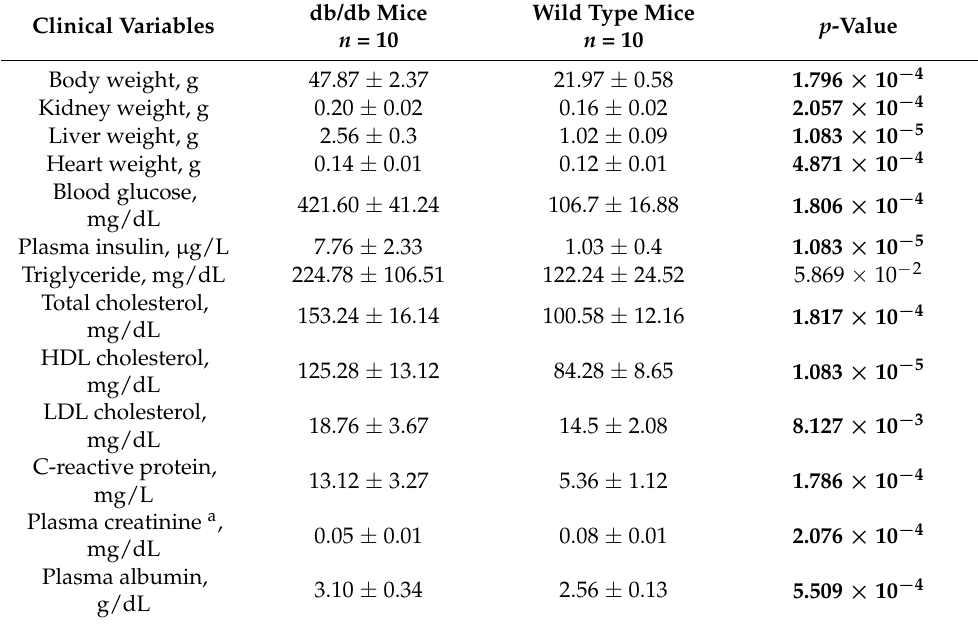
Table 4. Phenotypic and metabolic variables in db/db and wild type mice after 5 weeks of a high-fat diet. Values are mean ± SD. p -values were calculated by Mann–Whitney U test. p -values shown in bold represent statistical significance at the 0.05 level. Abbreviations: db/db, leptin receptor-deficient mouse model; HDL, high-density lipoprotein; LDL, low-density